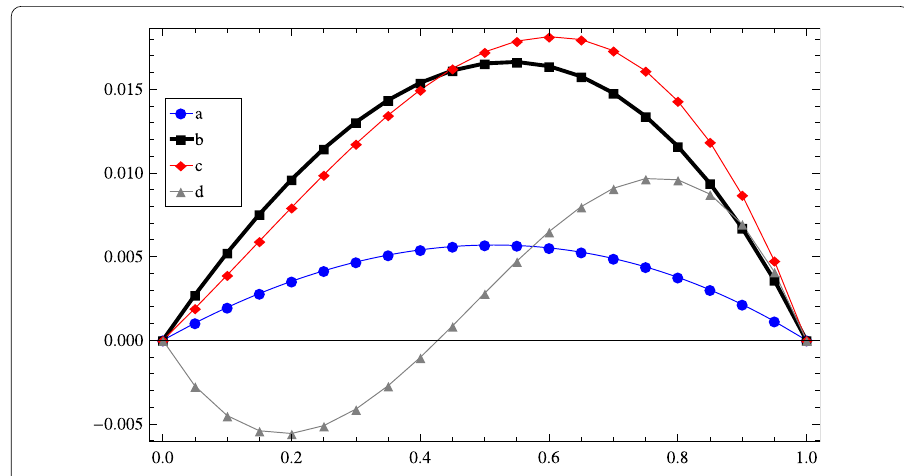
Figure 11 a : ε 0.1,0.25 ( x ), b : ε 0.25,0.5 ( x ), c : ε 0.5,0.75 ( x ), and d : ε 0.75,1 ( x ) for n = 1 and ν 0 = 1